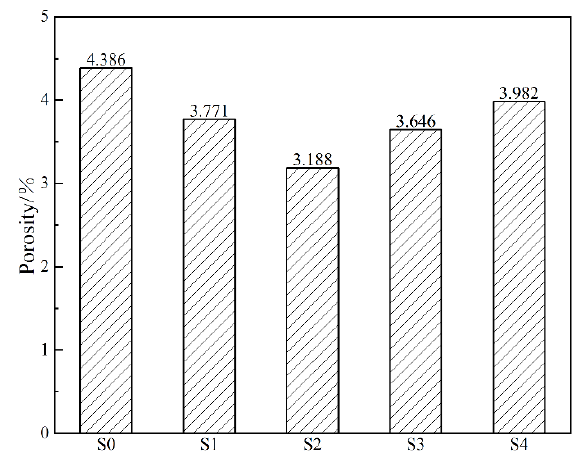
Figure 4. Porosity of MAO coatings.